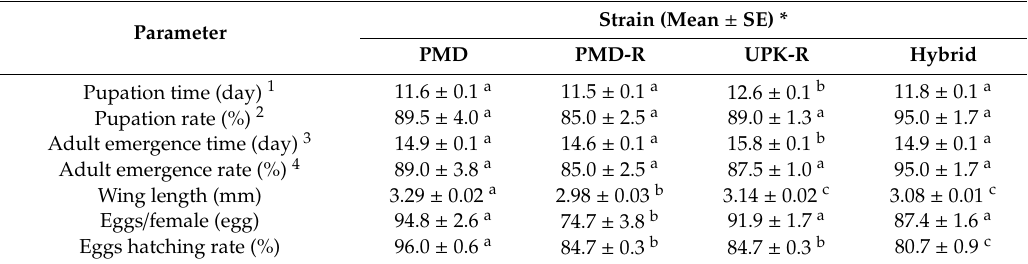
Table 1. Comparison of life-trait parameters of PMD, PMD-R, and UPK-R strains and F 1 (PMD-R × UPK-R)